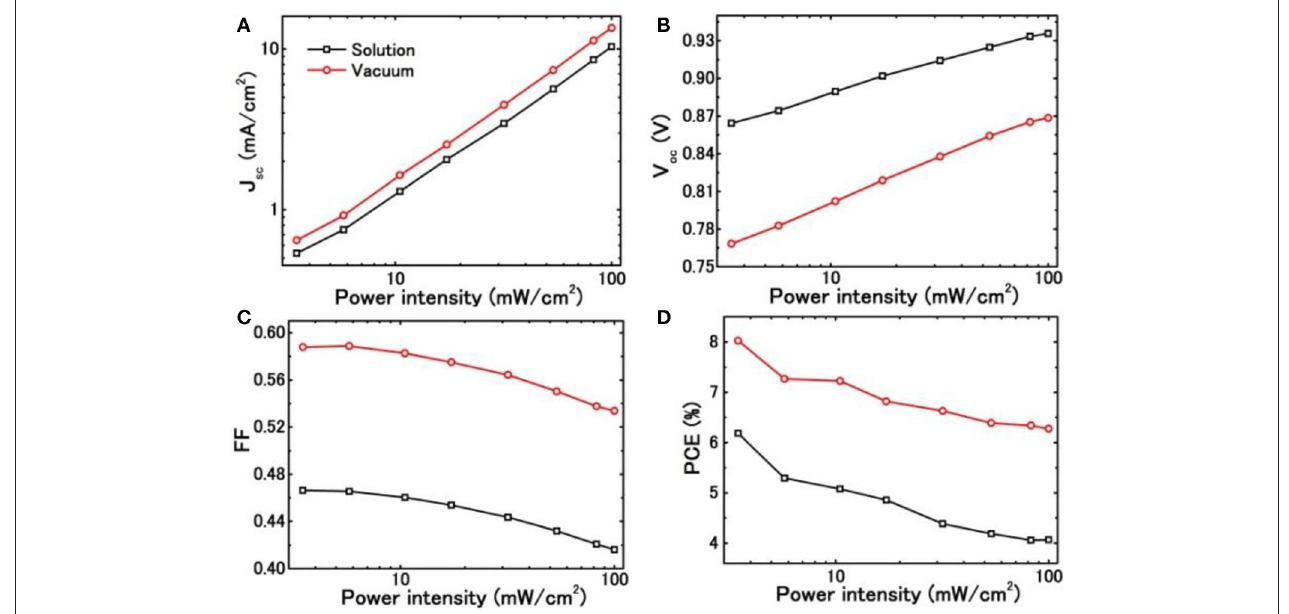
FIGURE 6 | AFM topographic and 3D images of (A) the solution-processed DIBSQ:PC 71 BM (1:5, 60nm) film and (B) the vacuum-processed DIBSQ:C 70 (1:5, 60nm) film.